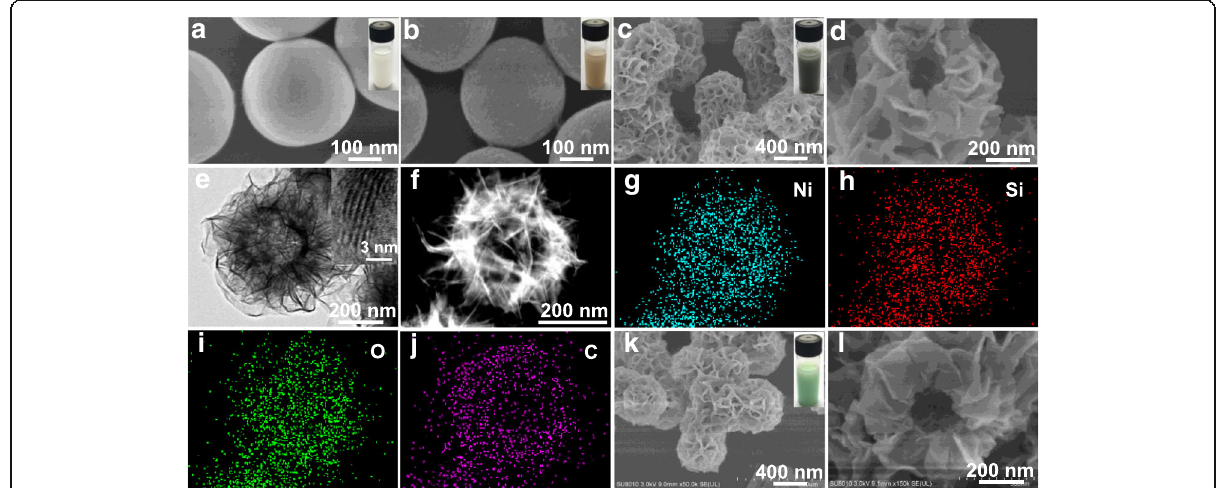
Fig. 2 a , b FESEM images of pristine SiO 2 and SiO 2 /GO microspheres, showing the smooth and relatively rougher external surface, respectively; the insets in a and b are digital photographs of the corresponding aqueous suspensions of SiO 2 and SiO 2 /GO microspheres, which are pure white and yellow brown in color, respectively. c , d FESEM images of as-prepared Ni 3 Si 2 O 5 (OH) 4 /RGO composite hollow microspheres at low and high magnifications, respectively; the inset in c is a digital photograph of their aqueous dispersion, showing dark black in color. e TEM image of an individual Ni 3 Si 2 O 5 (OH) 4 /RGO hollow microsphere; the inset is an HRTEM image of a random nanoflake located on its surface, displaying the (002) lattice plane. f STEM image of a single Ni 3 Si 2 O 5 (OH) 4 /RGO hollow microsphere. g – j EDS mapping images of elements Ni, Si, O, and C for the Ni 3 Si 2 O 5 (OH) 4 /RGO microsphere shown in f. k , l FESEM images of bare